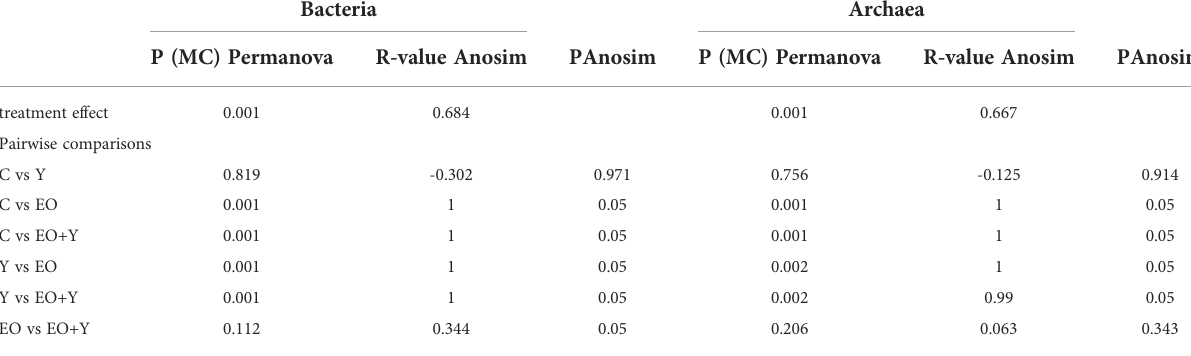
TABLE 4 Effect of supplementing a control diet (C) with oregano oil (EO), yeast (Y) or a combination of both (EO+Y) on the structure of the bacterial and methanogens communities in the RUSITEC